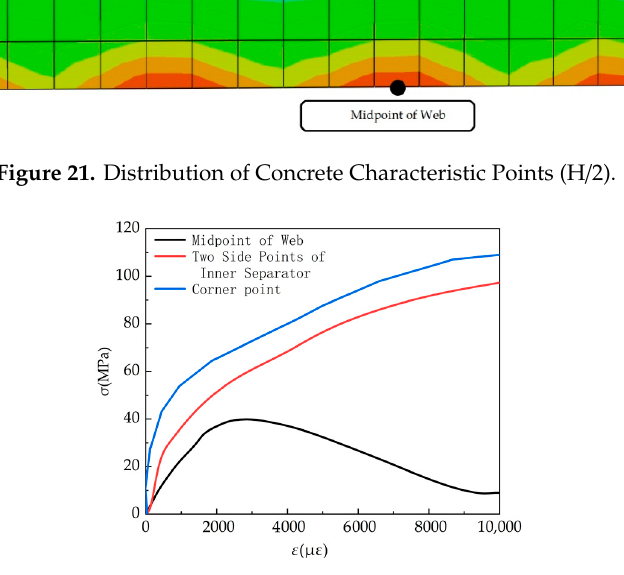
Figure 22. Longitudinal stress-strain relationship curves of concrete at various points under peak load.